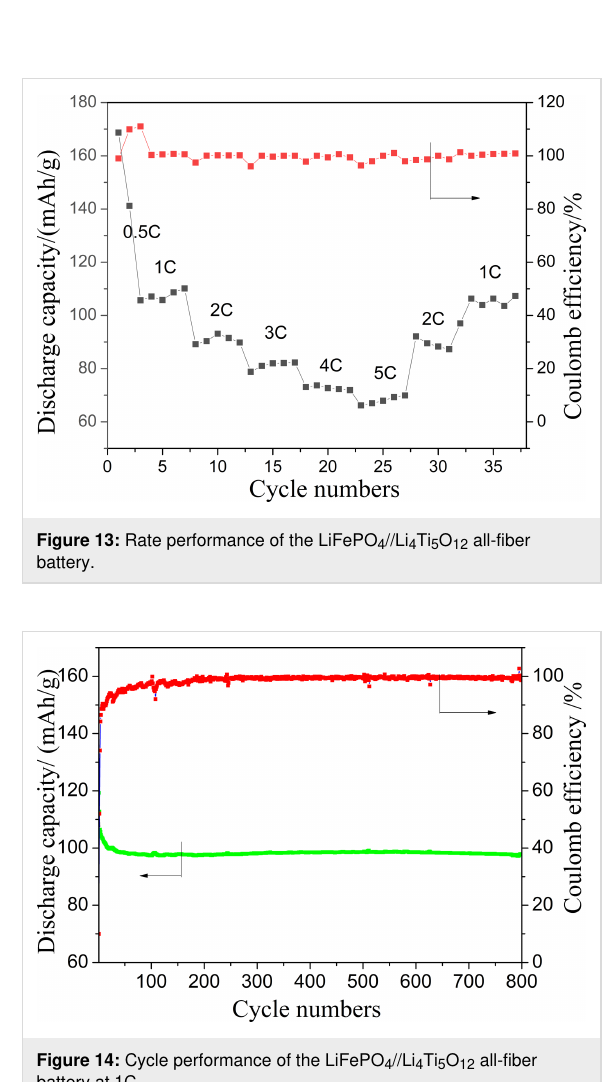
cycled at 1C for 800 times. Figure S2 (Supporting Information